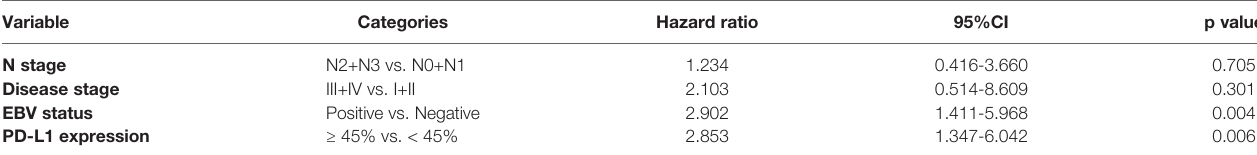
TABLE 3 | Multivariate analysis of progression-free survival in patients with